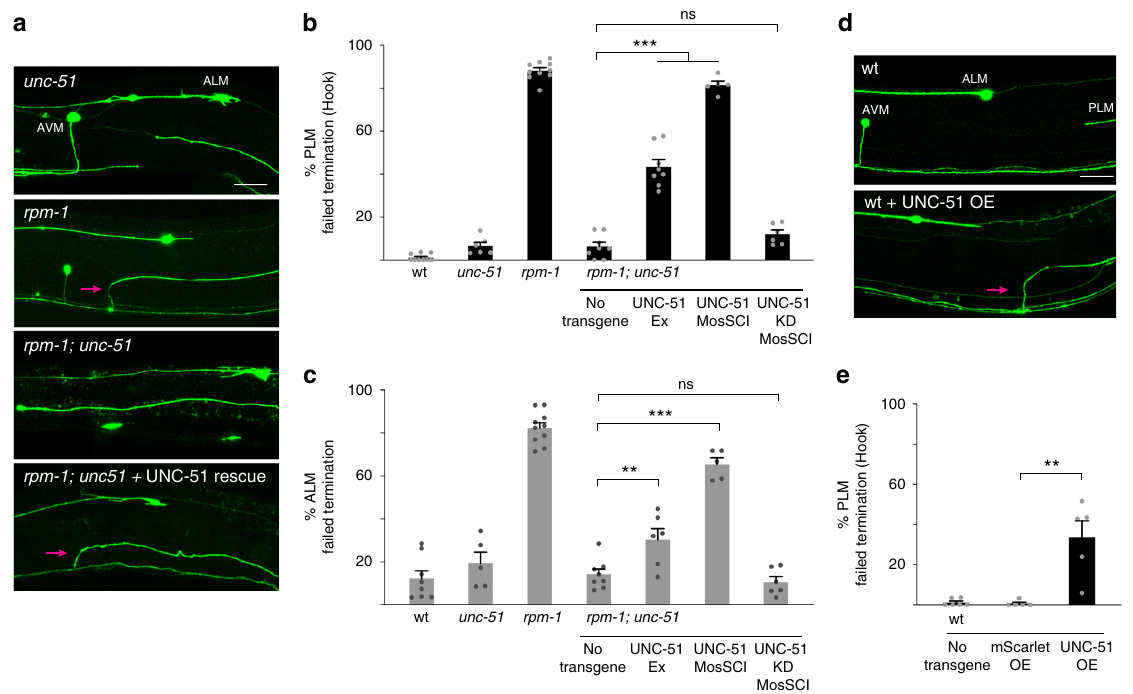
Fig. 4 UNC-51 kinase activity functions cell autonomously to negatively regulate axon termination. a Representative images of PLM axons for indicated genotypes. Severe failed termination defects (magenta arrow) in rpm-1 mutants are suppressed in rpm-1; unc-51 double mutants and rescued by expressing UNC-51 in mechanosensory neurons. b Quantitation of failed termination defects in PLM neurons for indicated genotypes (Ex, extrachromosomal array, KD, kinase dead). c Quantitation of failed termination defects in ALM neurons for indicated genotypes. d Representative images of PLM neurons for indicated genotypes. Transgenic overexpression of UNC-51 in mechanosensory neurons causes severe failed termination defects (magenta arrow, hook). e Quantitation of severe failed termination defects (hook) in PLM neurons for indicated genotypes. Means are shown from 5 to 8 counts (20 – 35 animals/ count) for each genotype, and error bars represent SEM. Signi fi cance determined using Student ’ s t -test with Bonferroni correction. ** p < 0.01; *** p < 0.001; ns, not signi fi cant. Scale bars 20 μ m. Source data are provided as a Source Data fi